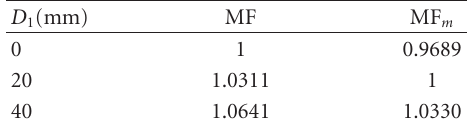
Table 1: Results of MF M calculations for di ff erent D 1